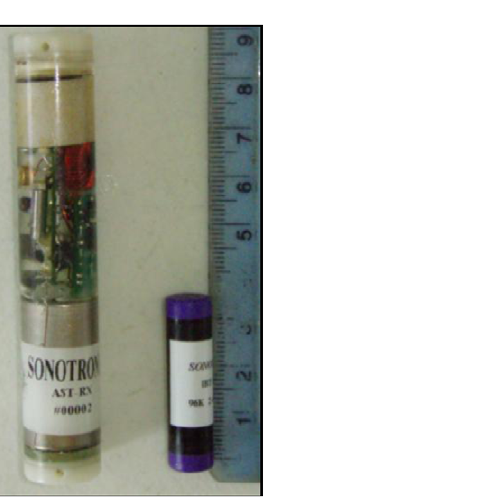
Figure 2. Animal-attached/implanted proximity detector. Ex- ample of the ARX acoustic receiver (left) and IBT transmitter (right) used in the study on lemon sharks.